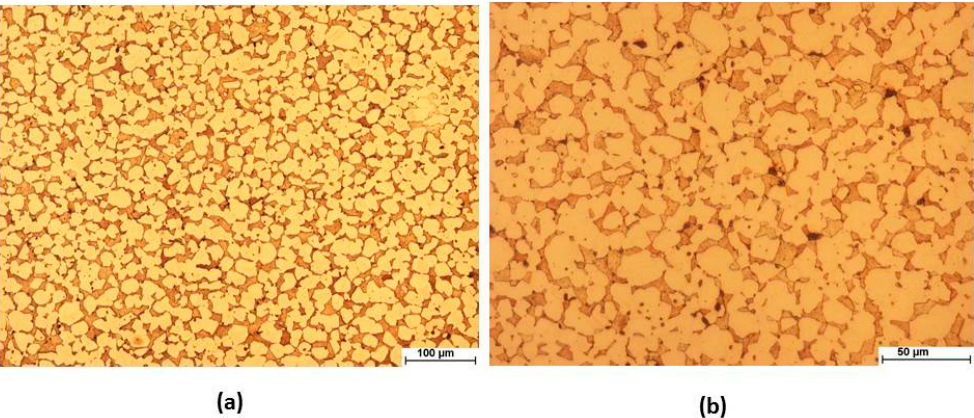
Figure 3. ( a ) Optical micrograph of the microstructure of a typical dual-phase brass on transverse section. ( b ) Detail of ( a ). Bright areas represent α -phase and dark areas represent β -phase. In ( a ) there is an appreciable amount of Pb particles, which appeared as black dots. Immersion etching in FeCl 3 -based solution.